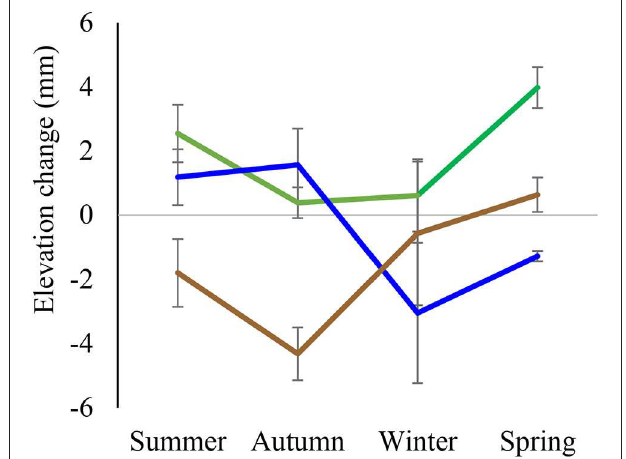
FIGURE 7 | Average changes in sediment elevation between seasons measured in each of the study areas; Natural = green, Restored = blue, and Mudflat = brown. Four Sediment Elevation Bar (SEB) in each area were measured once per season, each SEB consisted of 11 measurments, data shown is average change across each area. Standard error bars taken from across measurments at each site in each season. TABLE 1 | Estimate of sediment deposition dry weight taken from deposition rate data (assuming a constant accretion and full sediment retention) and actual elevation change (applying a bulk density conversion to generate a dry weight) and the difference in assumed constant deposited accretion and actual accumulation